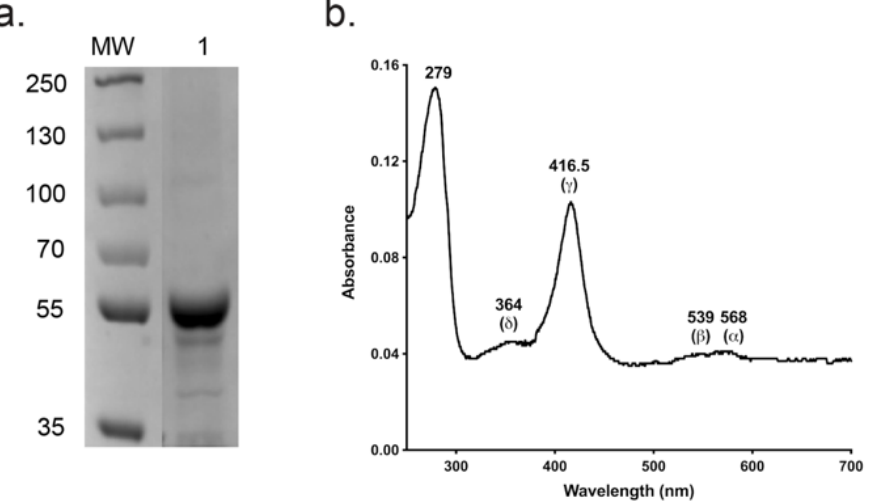
Figure 5. Analysis of SEC-purified CpCYP51-6 × His. ( a ) Coomassie-stained SDS-PAGE profile of purified wild type CpCYP51-6 × His (~59.5 kDa). MW: 5 µ L protein molecular weight markers (PageRuler Plus pre-stained protein ladder, Thermo Scientific). ( b ) Absolute absorbance spectrum of the SEC-purified CpCYP51-6 ×